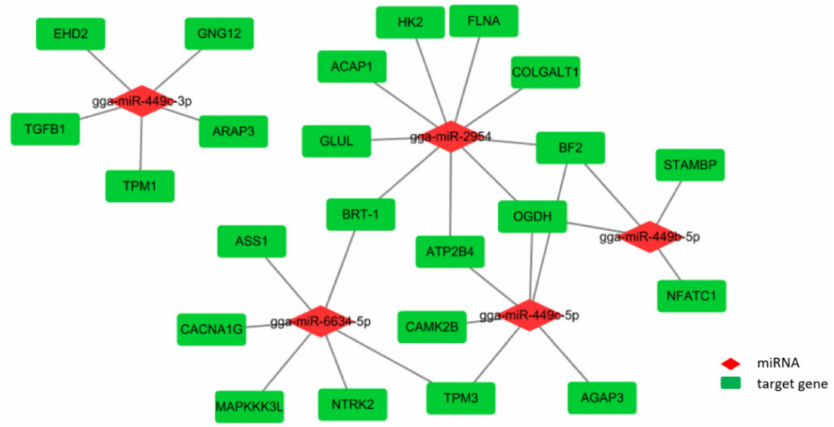
Figure 4. Integrated key miRNA-mRNA network. The red rhombus and green rectangle represent the key miRNAs and predicted target genes,